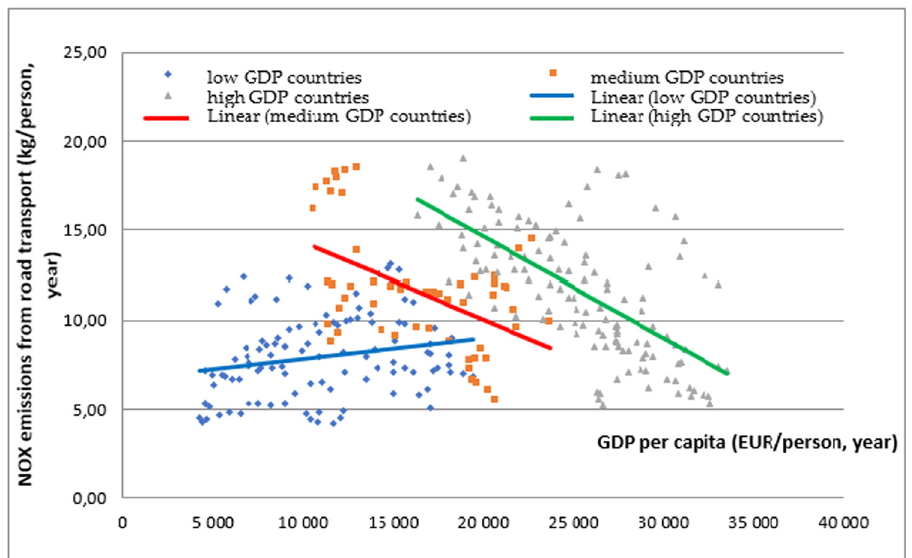
Figure 6: Dependence of NOx emissions from road transport on GDP – linear approximation, data source: http://epp.eurostat.ec.europa.eu/ portal/page/portal/eurostat/home/; UNFCCC, own calculations.